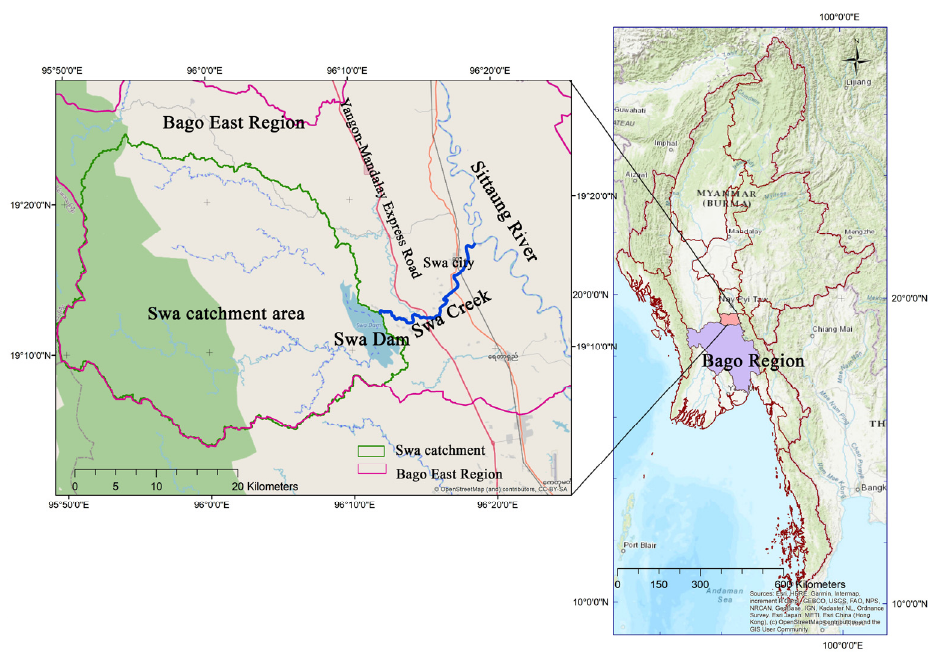
Figure 1. Location of the study site, Bago Region, Myanmar.